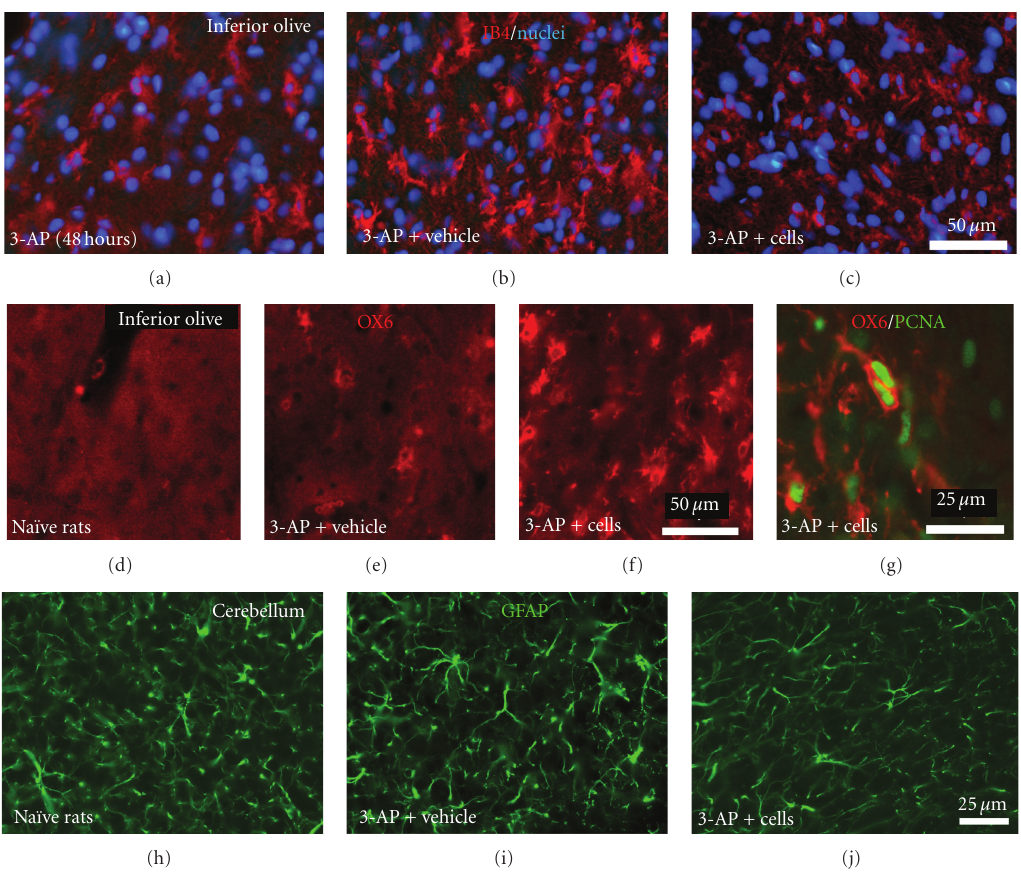
Figure 5: Immunodetection of glial cells in the inferior olive and cerebellum of 3-AP ataxic rats. (a) and (b) show the histochemical detection of isolectin B4 (IB4, red) in the inferior olive of 3-AP-lesioned rats 48 hours (a) and 10 days (b, c) after lesion. Note how 3-AP lesioned rats that received HuUCBMCs grafts (c, red) show lower IB4 staining at 10 days after lesion than ataxic rats treated with vehicle (b, red). (d) to (g) show OX6 immunostaining in the inferior olive of na¨ıve rats (d, red) and 3-AP-lesioned rats treated with vehicle (e, red) or HuUCBMCs (f, red). Cell transplantation increases OX6 immunoreactivity (f, red). (g) shows double immunolabeling for OX6 (red) and PCNA (green) in the inferior olive of 3-AP + cells-treated rats. (h) to (j) show GFAP immunoreactivity in the cerebellum. Note how HuUCBMCs grafts reduce GFAP immunolabeling in this structure (j, green). Nuclei were counterstained with Hoechst 33342 (blue). Scale bar: 25 μ m (g, h, I, and j), 50 μ m (a, b, c, d, e, and